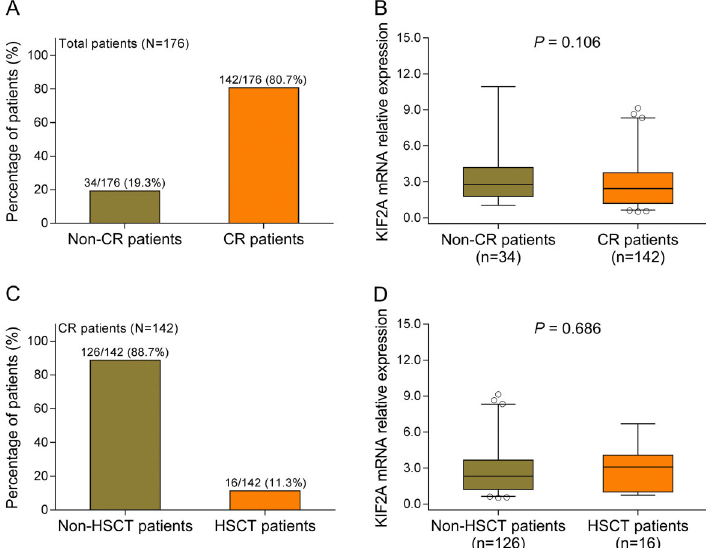
(HSCT). D , KIF2A mRNA expression in HSCT patients and non-HSCT patients. Data are reported as median and inter-quartile range. P o 0.05 was considered signi fi cant (chi-squared test). KIF2A: kinesin family member 2A; mRNA: messenger RNA.